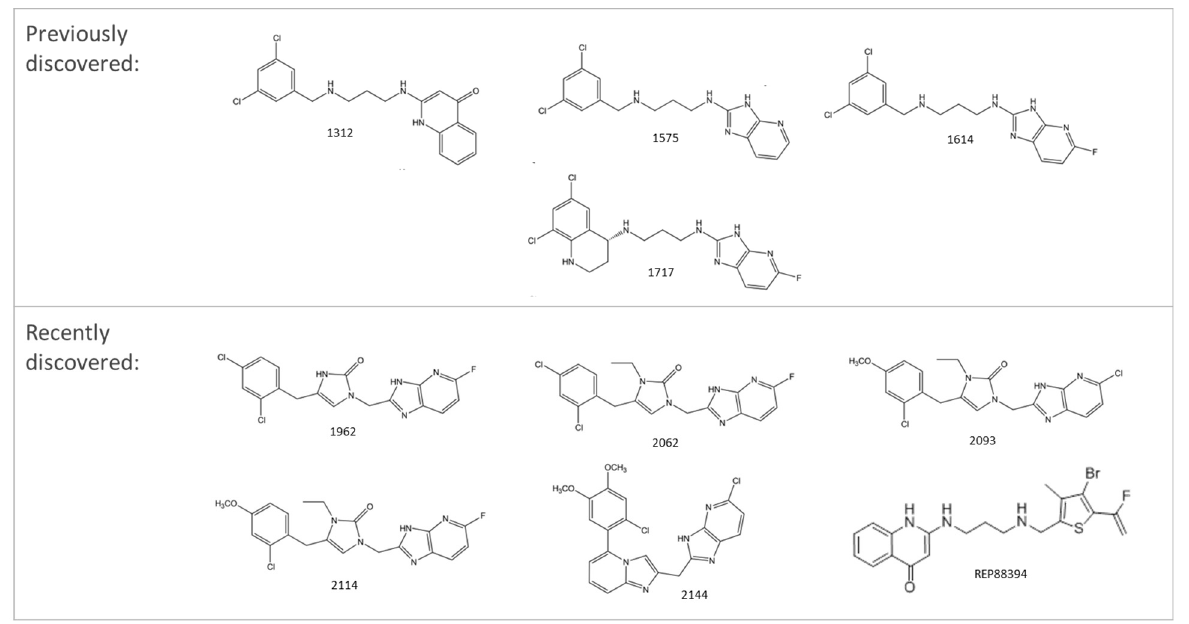
Figure 4. Chemical structure of MetRS inhibitors. This chemical structure was prepared based on Faghhih et al., (2017) [88]; Shibata et al., (2011) [93]; and Zhanz et al., (2016) [94].